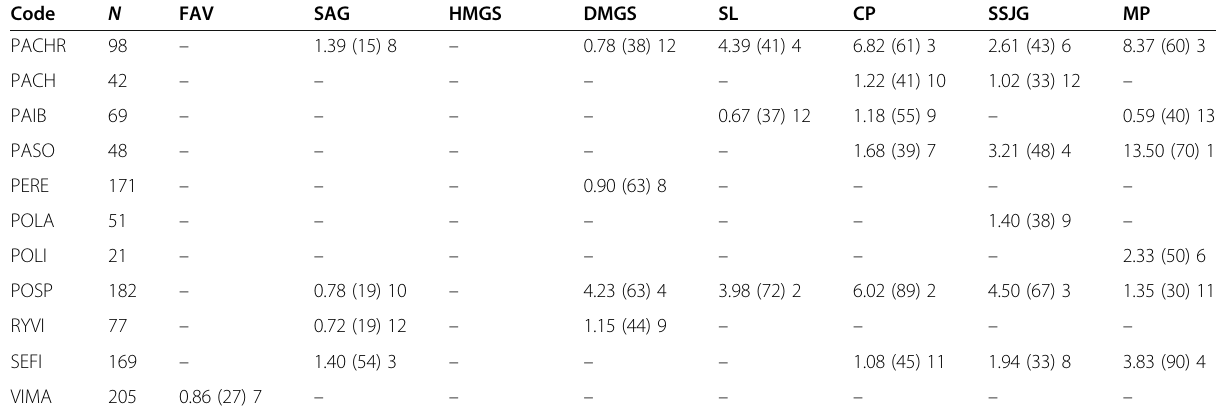
Table 1 Code for vascular plant species, number of presence point ( N ), mean cover (%), and frequency of occurrence (%) between brackets, followed by the rank (1 to 15) for the most important species of each ecological area ( FAV forests and alpine vegetation, SAG sub-Andean grasslands, HMGS humid Magellanic grass steppes, DMGS = dry Magellanic grass steppes, SL shrublands, CP central plateau steppes, SSJG shrub-steppes of San Jorge Gulf, MP mountains and plateaus) (Continued) Code – – –